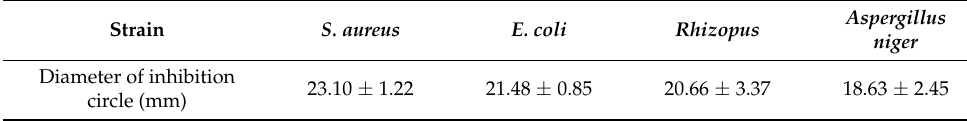
Data represent mean ± standard deviation (n =